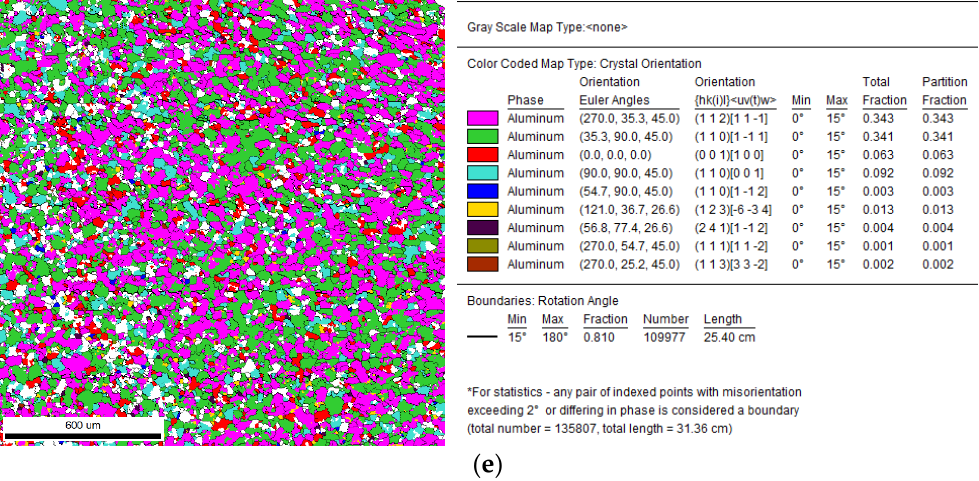
Figure 7. Microstructure of AA7075 in initial state. ( a ) Grain size of AA7075 in the initial state; ( b ) misorientation angle of AA7075 in the initial state; ( c ) grain boundary distribution of AA7075 in initial state; ( d ) GOS diagram of AA7075 in initial state; ( e ) crystal orientation distribution of AA7075 in initial state.